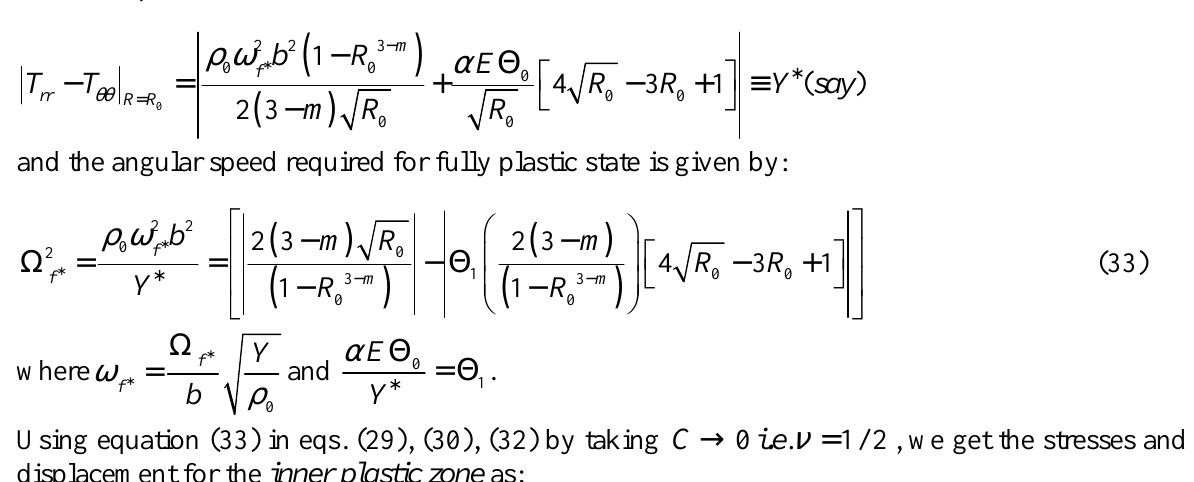
Figure 2. Two different plastic zones around the disc for fully plastic